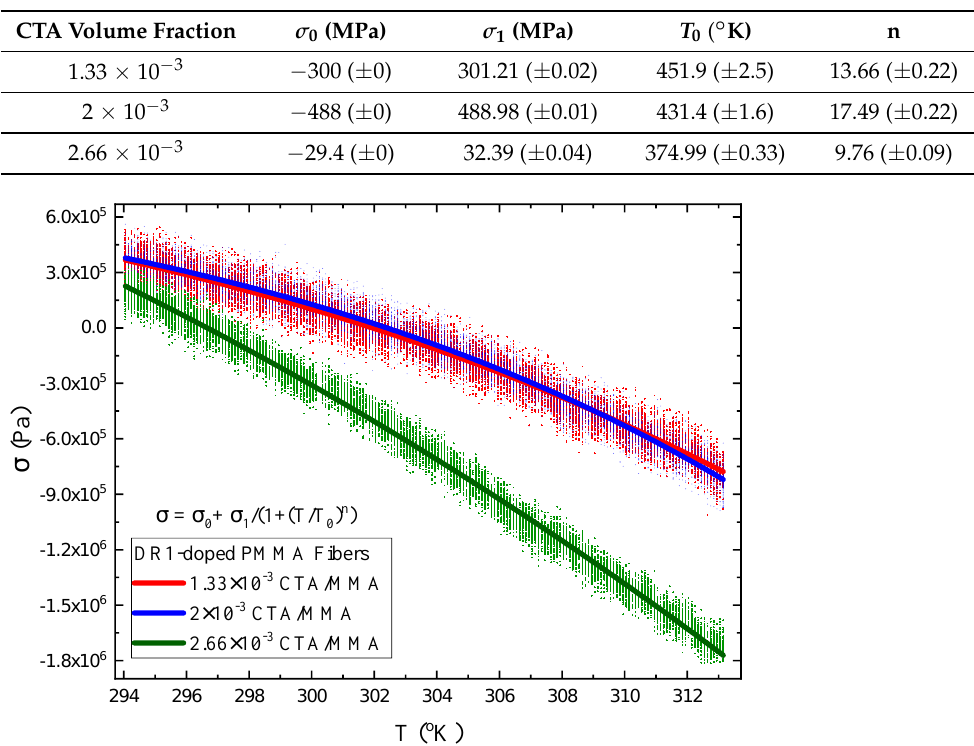
Table 2. The parameters determined by fitting the temperature-dependent stress data in Figure 9 to Equation (6) for fibers with three different CTA volume fractions.